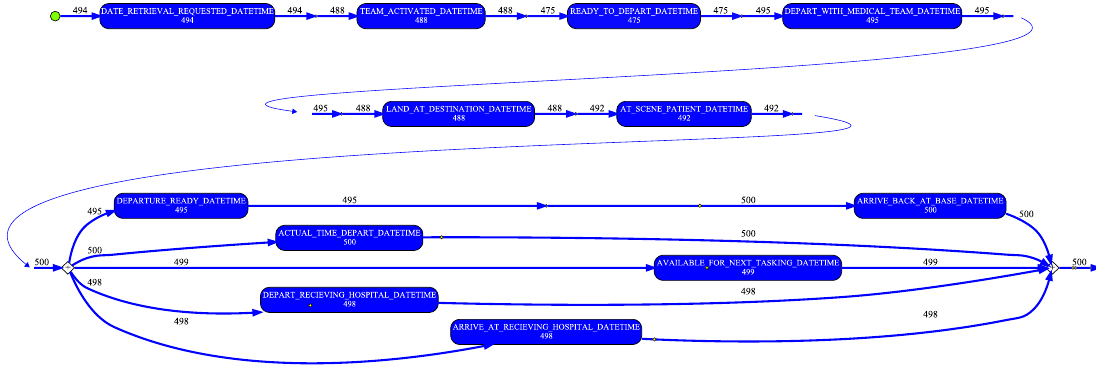
Figure 11. RSQ process model derived from sample